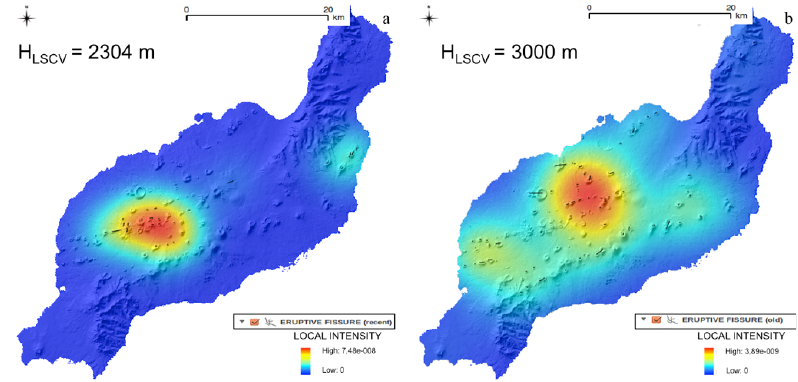
Fig. 8. PDFs calculated with the Gaussian kernel for the most recent (a) and the oldest (b) vent alignments of Lanzarote.